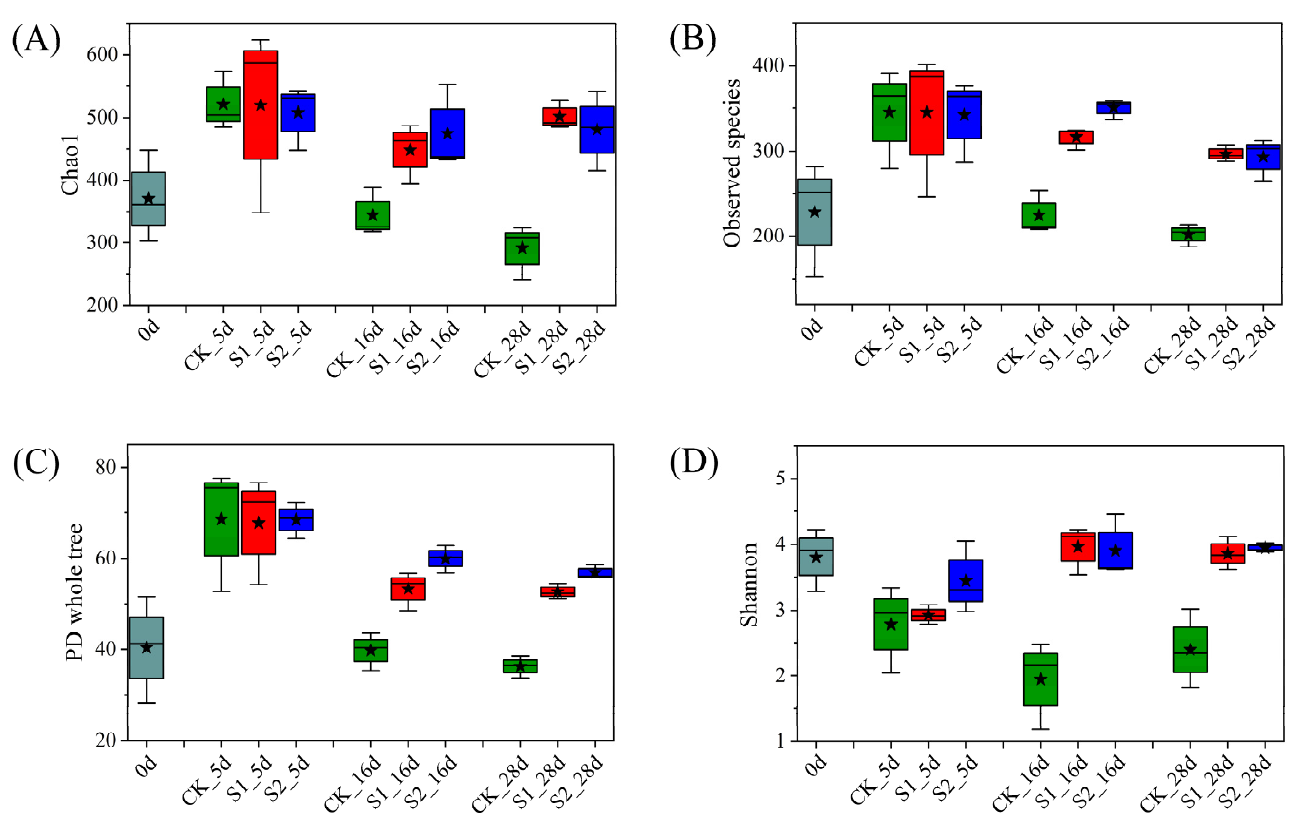
Figure 2. Fungal alpha diversity, ( A ) Chao1, ( B ) observed species, ( C ) PD whole tree, and ( D ) Shannon indices. ★ : the average .